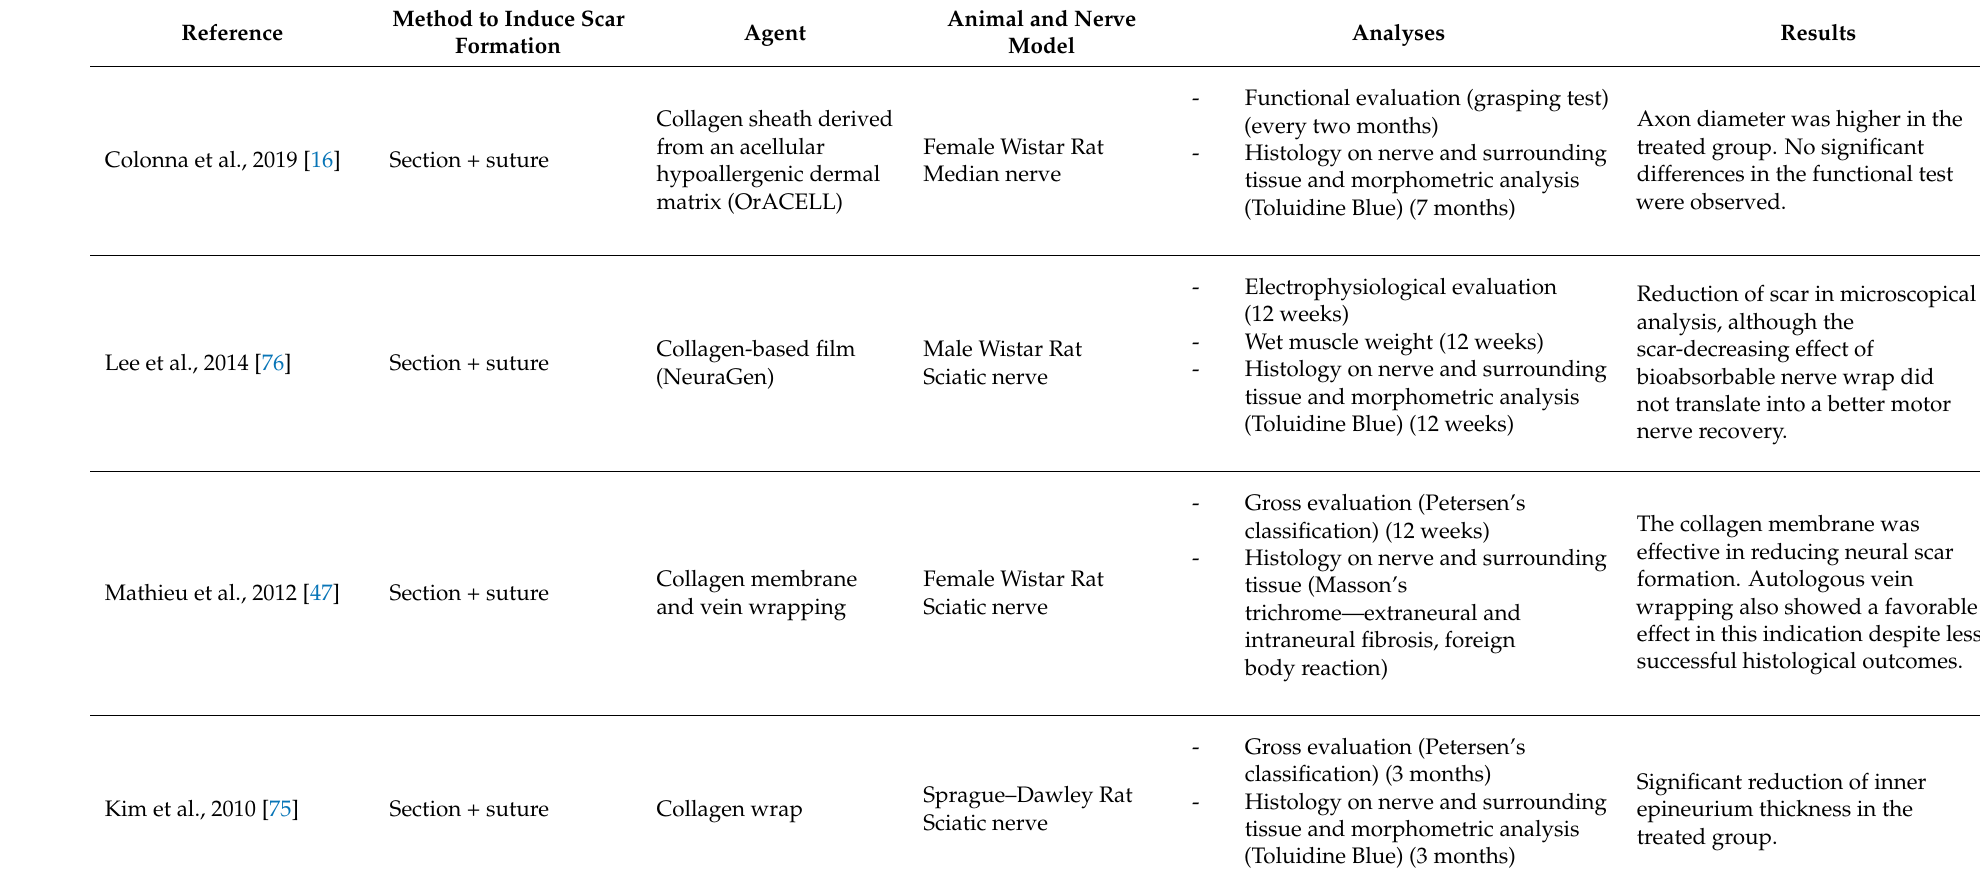
Table 3. Collagen-based antiscarring